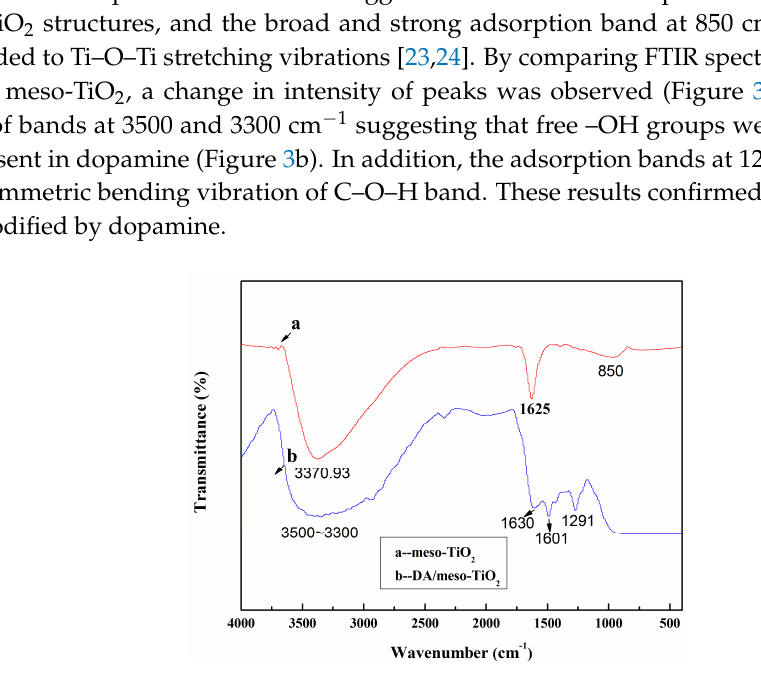
Figure 3. FTIR spectra of (a) meso-TiO 2 and (b) DA/meso-TiO 2 .